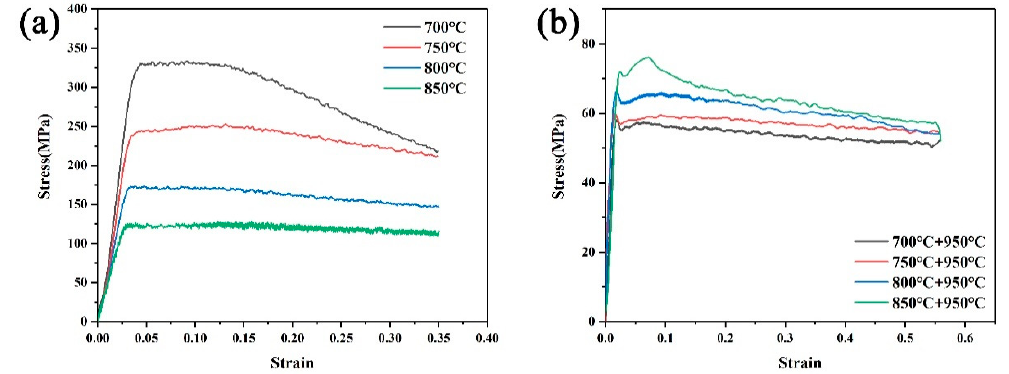
Figure 3. Stress-strain curves of duplex Ti-55511 during ( a ) first-pass and ( b ) second-pass thermal compression.